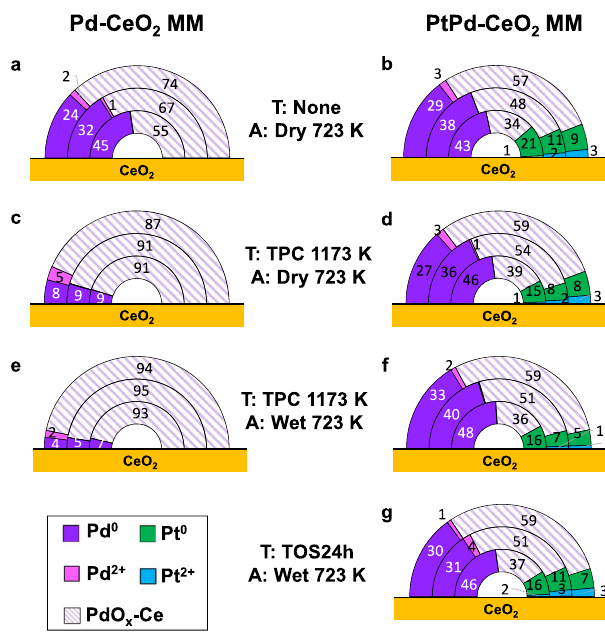
Fig. 5 | Palladium and Pt atomic fractions and oxidation states calculated for Pd-CeO 2 MM and PtPd-CeO 2 MM. a – d were acquired under dry lean methane oxidation conditions methane combustion mixtureand e – g under wet conditions. The outer semicircle corresponds to the data obtained with KE of 230eV, the intermediate semicircle corresponds to KE of 450eV, and the inner semicircle correspondstoKEof1000eV. T indicatesthepreviouspretreatmentperformedon the catalyst (TPC temperature-programmed combustion, TOS time-on-stream). A indicatesthegaseousatmospherepresentduringthemeasurements.Thenumbers indicate the atomic concentration. MM mechanical